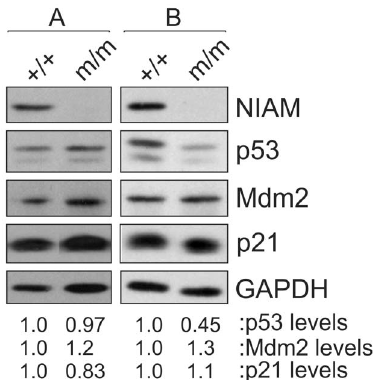
Figure 7. NIAM is not required for basal p53 activity in splenic B cells. Splenic B cells from young, tumor-free wild-type NIAM + / + or NIAM m/m homozygous mutant mice were isolated and expression of endogenous NIAM, p53, Mdm2 and p21 proteins was assessed by western blotting. Relative levels of p53, Mdm2 and p21 (normalized to GAPDH loading and compared to the untreated, wild-type control sample) were determined following quantification of bands using Image J. Representative results from 4 of 5 pairs of mice (both 8 week and 6 months of age) are shown in Set A, while Set B shows data for one pair of 6 month old mice. Set A and B samples were analyzed on separate gels, and lanes within each set were spliced together from the same autoradiogram for image